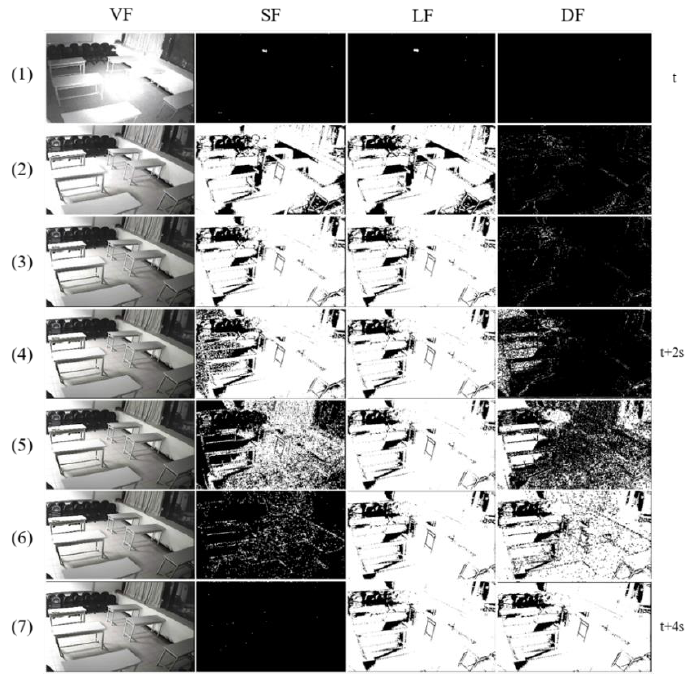
Sensors 2019 , 19 , x FOR PEER REVIEW 10 of 17